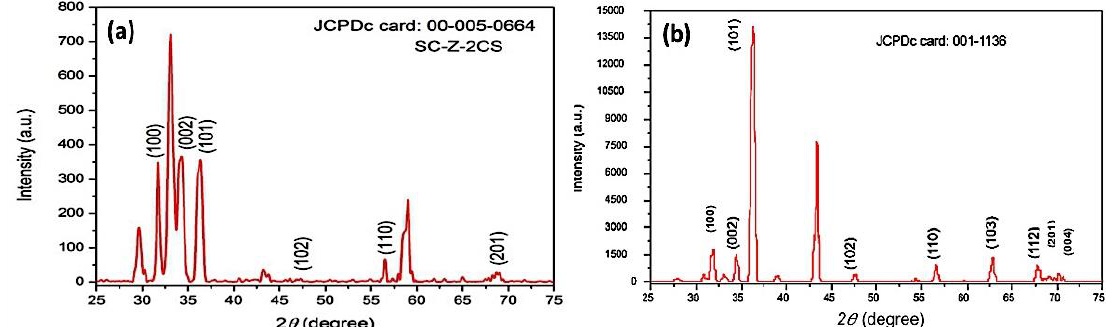
Figure 3. X-ray diffraction patterns of the investigated nanoparticles, where ( a ) the as prepared ZnO-NPs and ( b ) the ZnO-NPs after calcination at 500 °C.